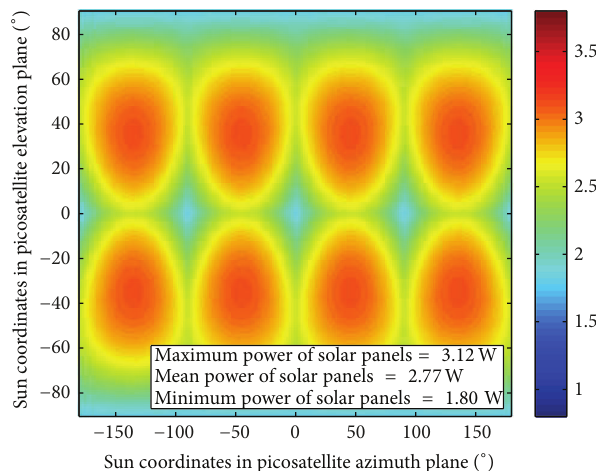
Figure 2: Power generation of silicon-based solar panels placed on CubeSat walls in dependence on Sun position.